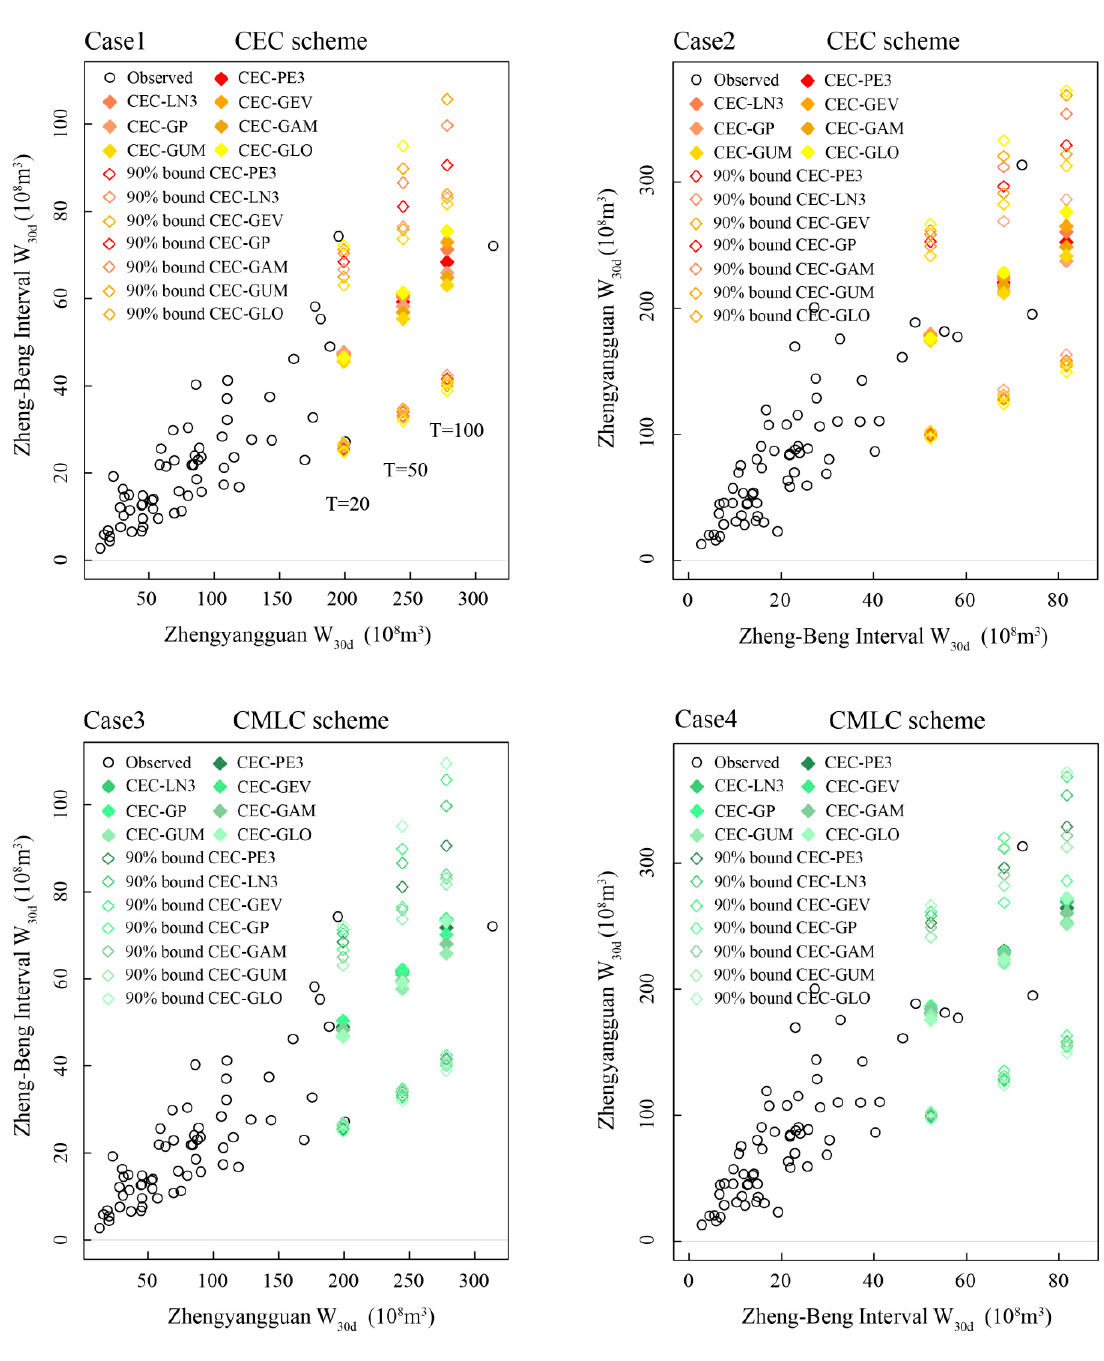
Figure 6. CEC and CMLC points under combinations of specified marginal distributions. Case 1 and Case 3 denote the CEC and CMLC points in the condition that the design flood (T = 20, 50, 100) occurs at the Zhengyuanguan section, respectively, while Case 2 and Case 4 denote the CEC and CMLC points in the condition that the design flood occurs at the Zheng-Beng interval, respectively. For better visualization, the horizontal and vertical coordinates of Case 2 and Case 4 have been exchanged